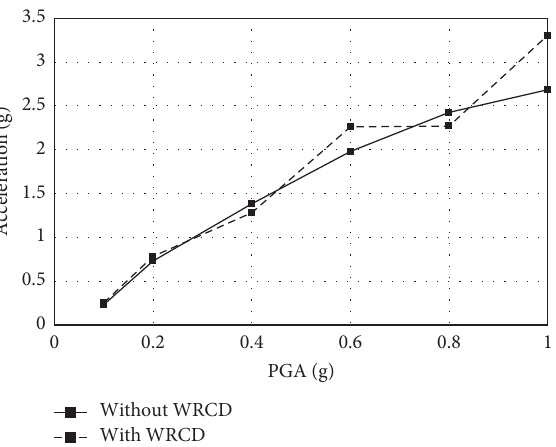
Figure 7: Maximum acceleration of 1# sliding pier